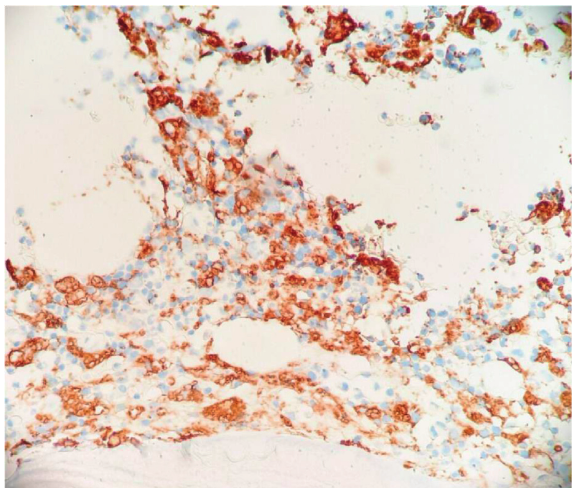
Figure 2: Bone marrow biopsy specimen. Immunopathology reveals positive staining for CD163, indicating moderately increased number of macrophages, some of them with hemophagocytosis.